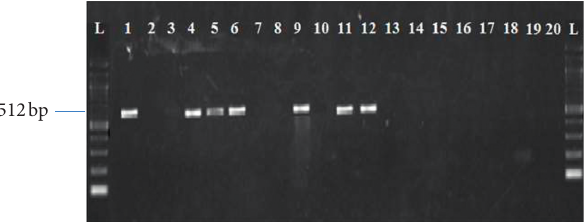
Figure 4: Detection of Tobacco mosaic virus in leaf samples of African nightshade in different agroecological zones using RT- PCR. L-DNA ladder. Samples 18, 14, and 10: UM2; samples 17, 13, and 9: LH2; samples 16, 12, and 8: UM4; samples 15, 11, and 7: LM2; 19: healthy control; 20: positive control. TMV �